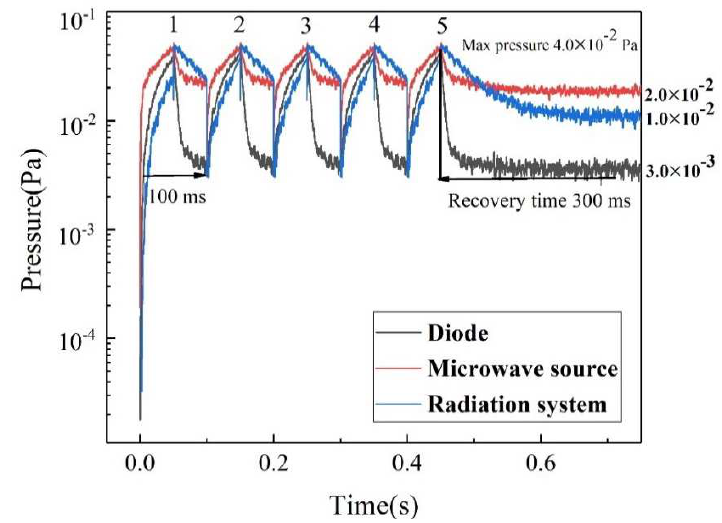
Figure 5. Pressure distribution at the three monitoring points.